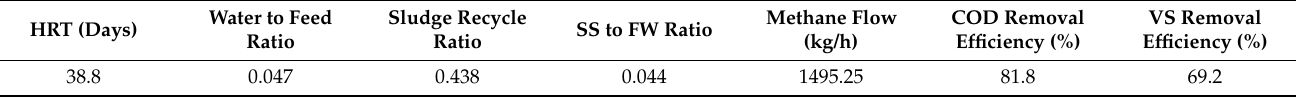
Table 7. Summary of optimum value of independent variables and estimated response value.